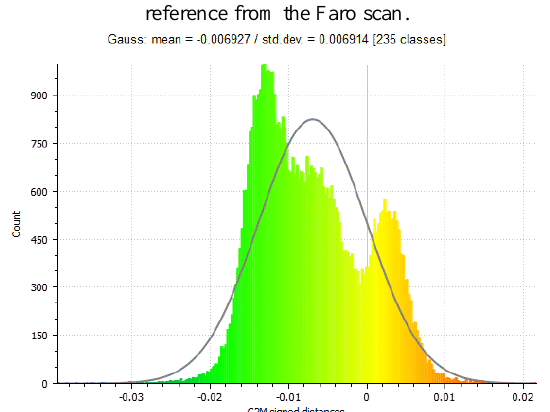
Figure 14a,b show the deviations over the entire object facade.